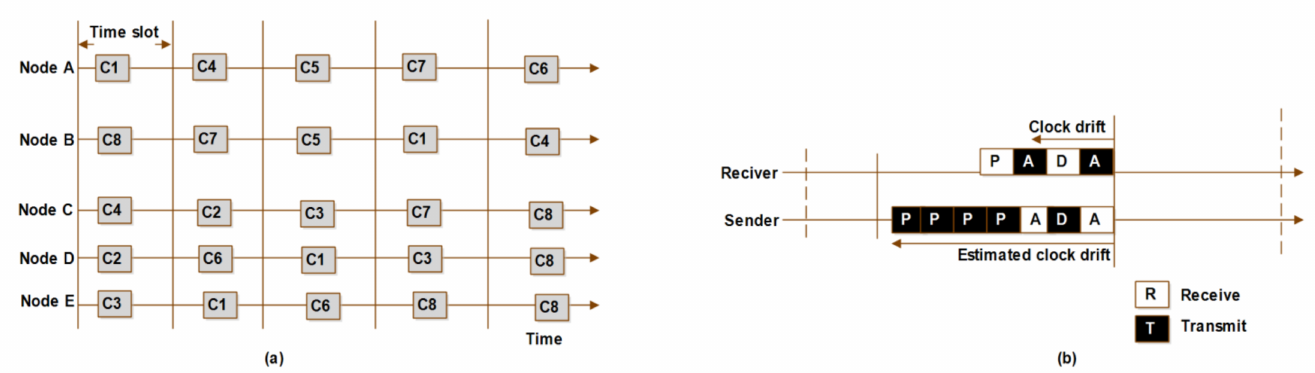
Figure 8. Y‑MAC frame structure.